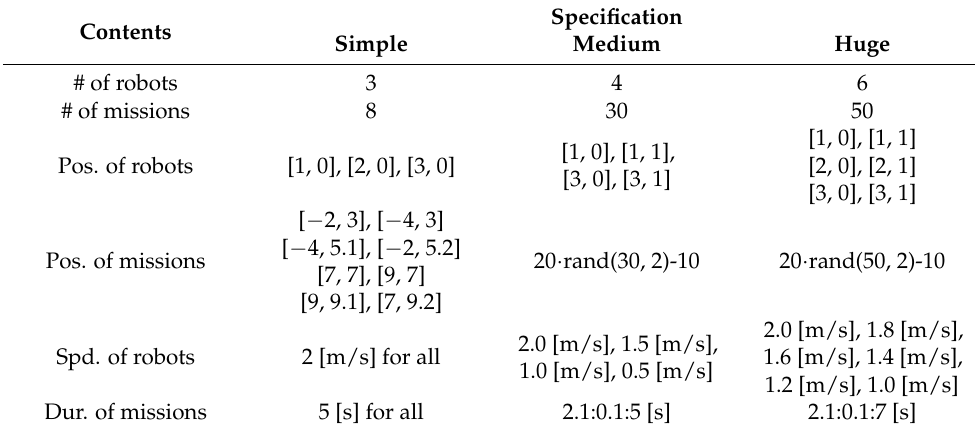
Table 3. The scenarios of simulations.